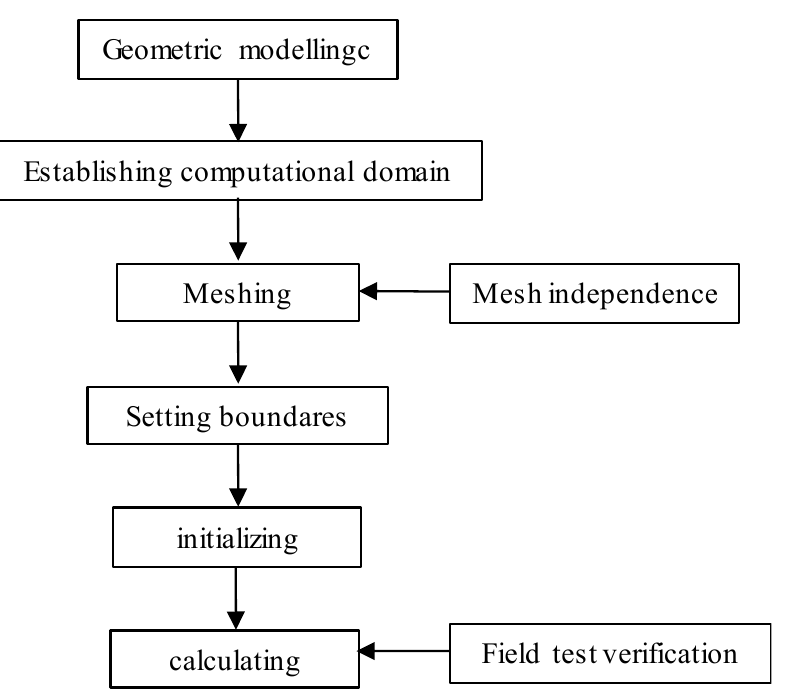
Figure 3. Calculation process.